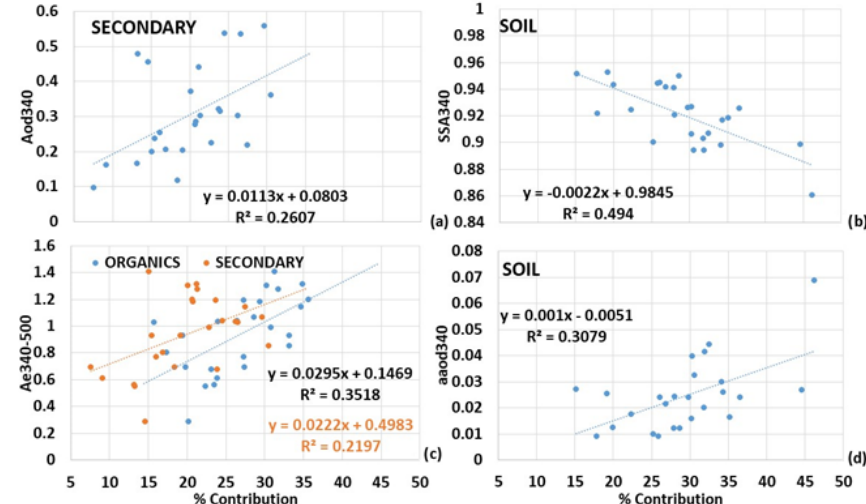
Figure 3. Behavior of AOD 340 , SSA 340 , Ae 340 − 500 , and AAOD 340 versus the percentage contribution of some components as retrieved during the URBS campaign.